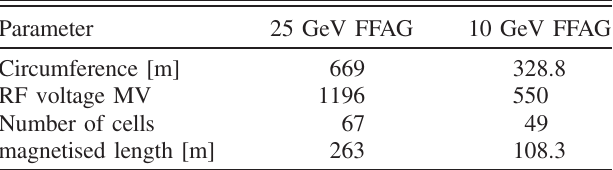
TABLE II. Final acceleration using the NS-FFAG. Comparison of design parameters for the fully designed and costed 12.6 – 25 GeV FFAG [21] with the first results for the 5 – 10 GeV FFAG proposed as an alternative to the two-RLA